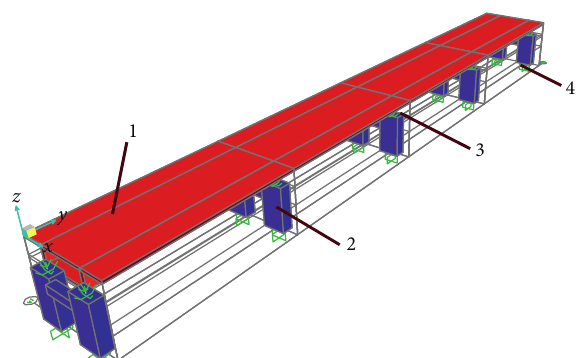
Figure 8: Time history of the energy response, T and peak acceleration is 0.4 g ; El Centro wave.